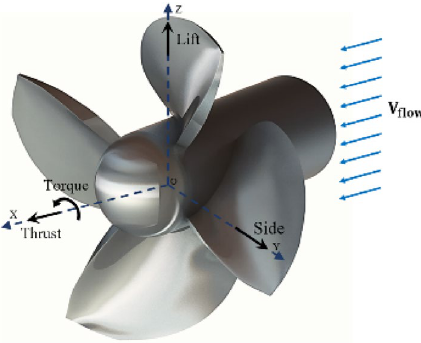
Figure 4. The forces and torque acting on the model propeller (Solidworks 2014, https:// www. solid works. com).